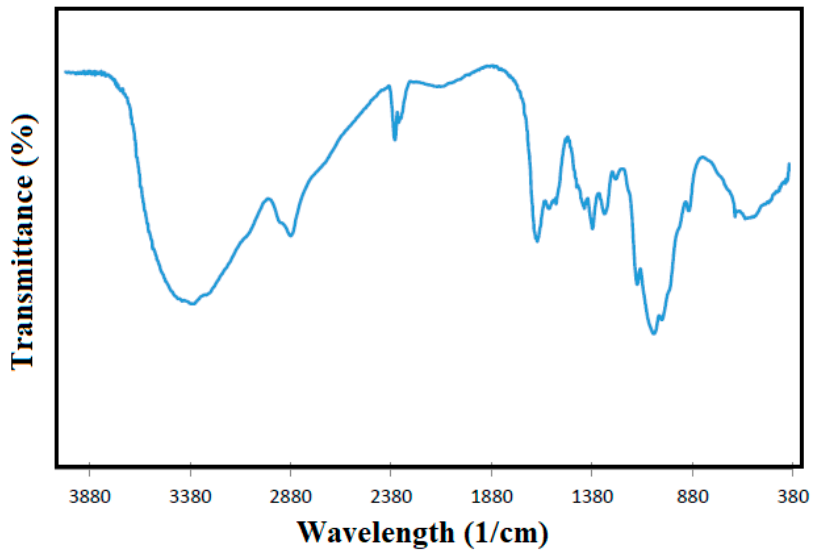
Figure 2. FTIR spectra of chitosan from shrimp shells.